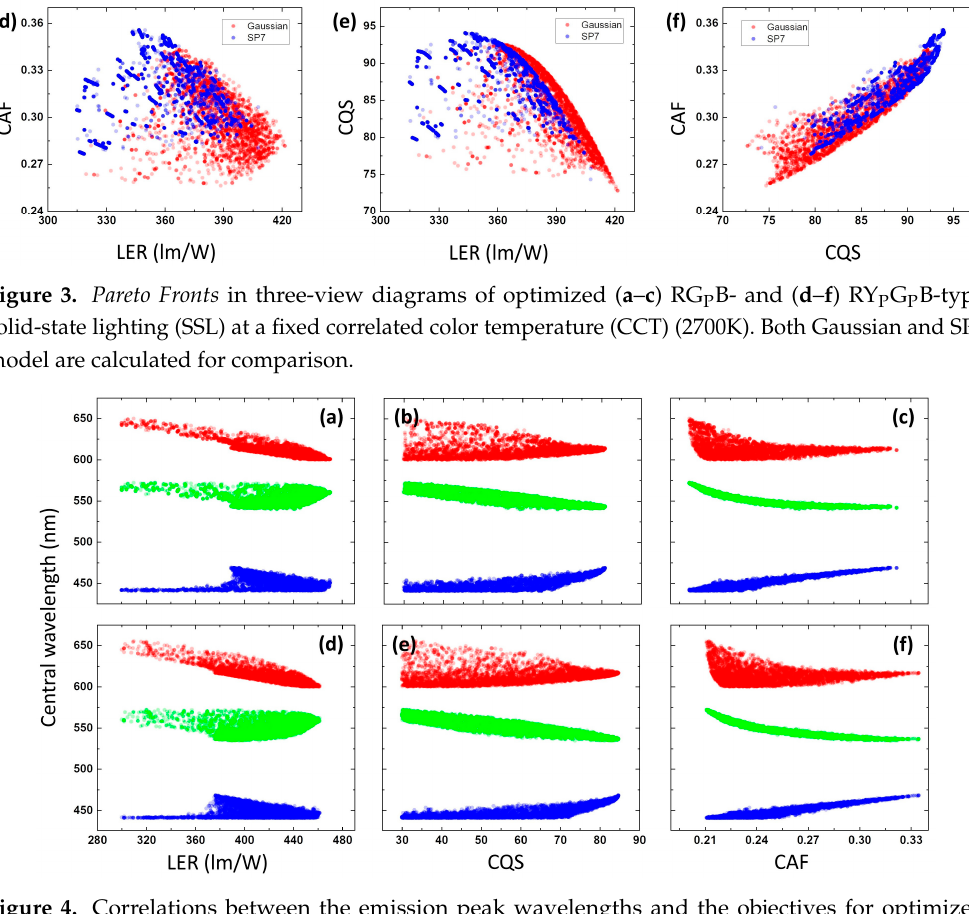
Figure 3. Pareto Fronts in three-view diagrams of optimized (a-c) RG P B- and (d-f) RY P G P B-type solid-state lighting (SSL) at a fixed correlated color temperature (CCT) (2700K). Both Gaussian and SP7 model are calculated for comparison.